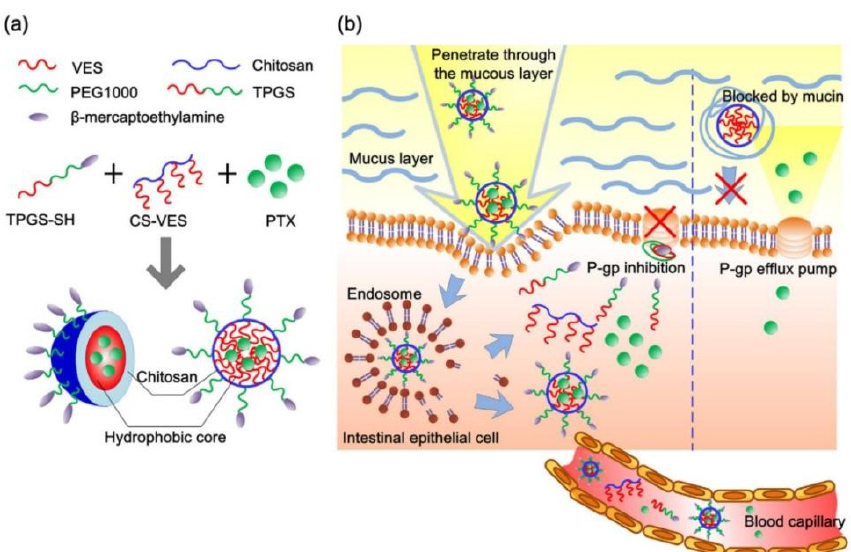
Figure 4. ( a ) Schematic drawing of self-assembled hybrid CS-VES/TPGS-SH nanomicelles in aqueous medium. ( b ) Schematic illustration of intestinal distribution of hybrid CS-VES/TPGS-SH nanomicelles, mucosal penetration, and subsequent P-gp inhibition for effective oral delivery of paclitaxel. Reprinted with permission from [94]. Copyright© 2017 Elsevier B.V.